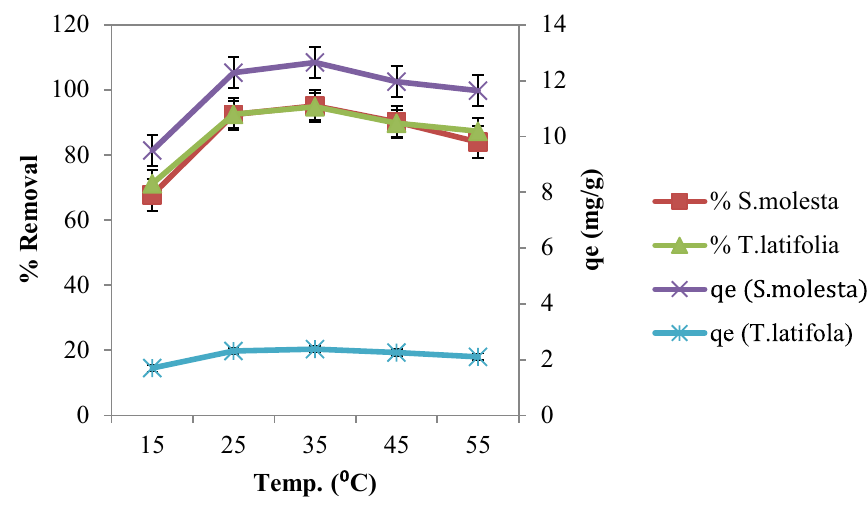
R > 1 for unfavorable adsorption, R = 1 for linear adsorp- L L tion, and R = 0 for irreversible adsorption. L From Fig. 10 and Table 1, the correlation coefficient values ( R 2 ) obtained were 0.980 and 0.831 for adsorbents S. molesta and T. latifolia , respectively. The value of R 2 for S. molesta favors the Langmuir isotherm while showing the unfitness to the equilibrium data for T. lati- folia . The separation factors ( R ) using Eq. (4) obtained L were 0.098 ( S. molesta ) and 0.2 ( T. latifolia ), which fell within the range, 0 < R < 1, showing the feasibility of L the adsorption process at all metal concentrations inves- tigated. Langmuir isotherm fits adsorption data indicate monolayer adsorption (Soni and Padmaja 2014).